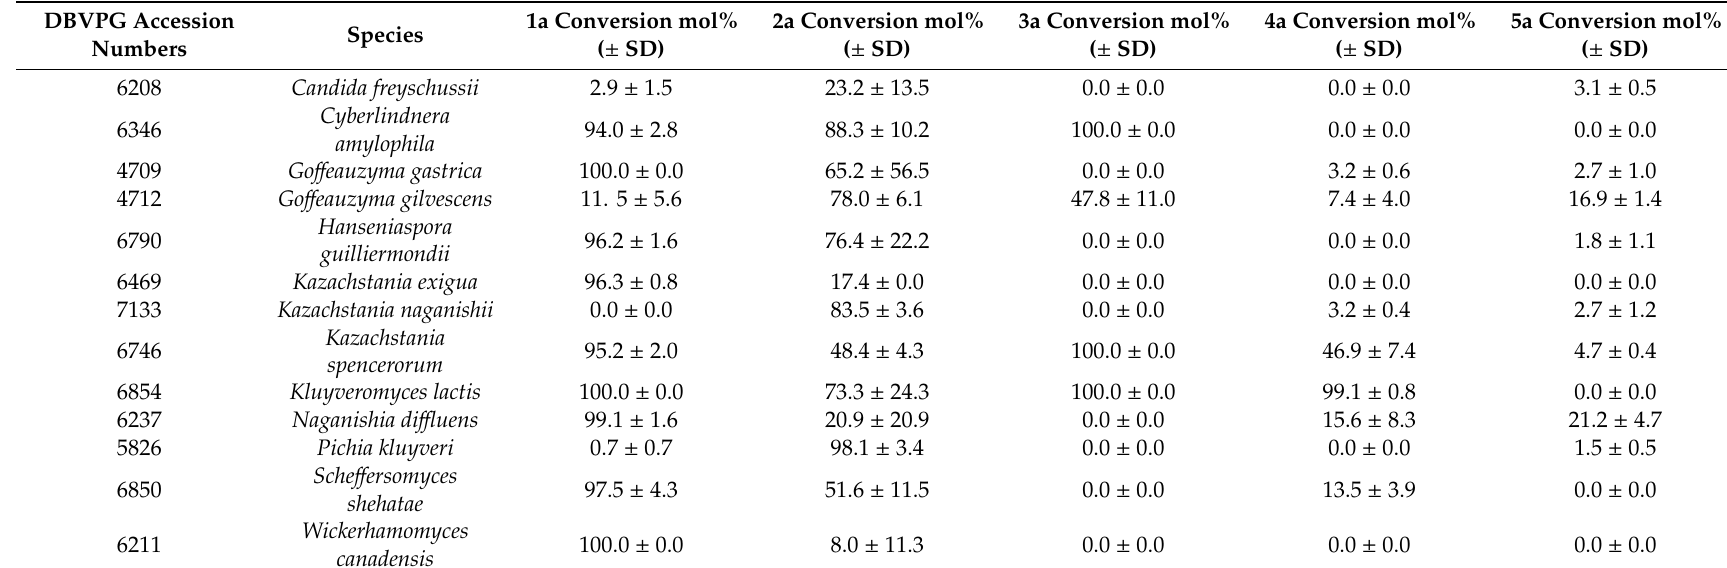
Table 2. Bioreduction yield of substrates 1a – 5a to products 1b – 5b by NCYs.( *